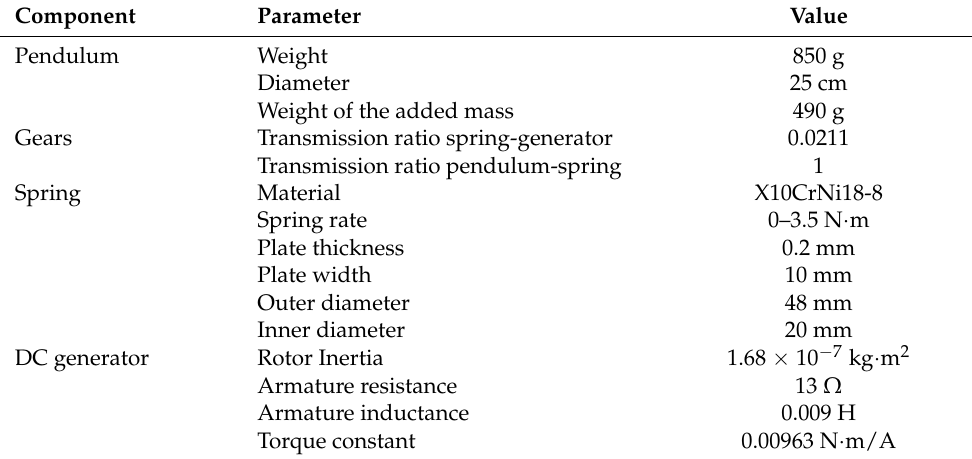
Table 1. Parameters used in the physical model.